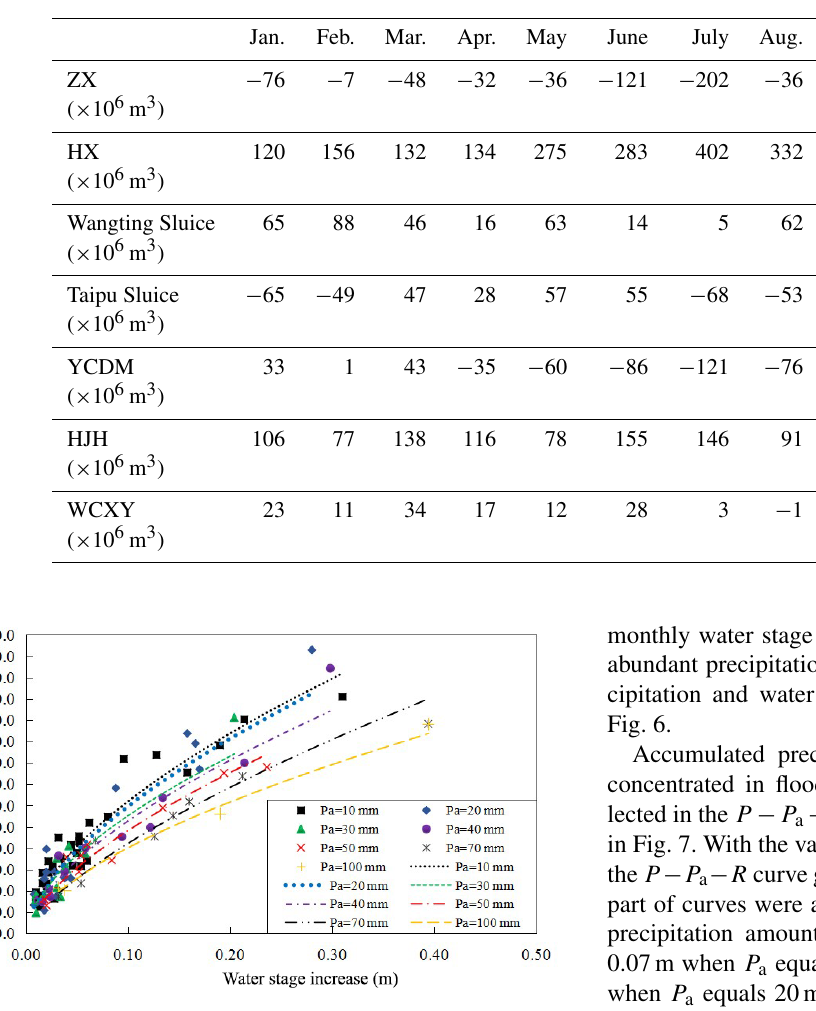
Table 7. Net inflow and outflow of Taihu Lake variation before 2001 and after 2002.